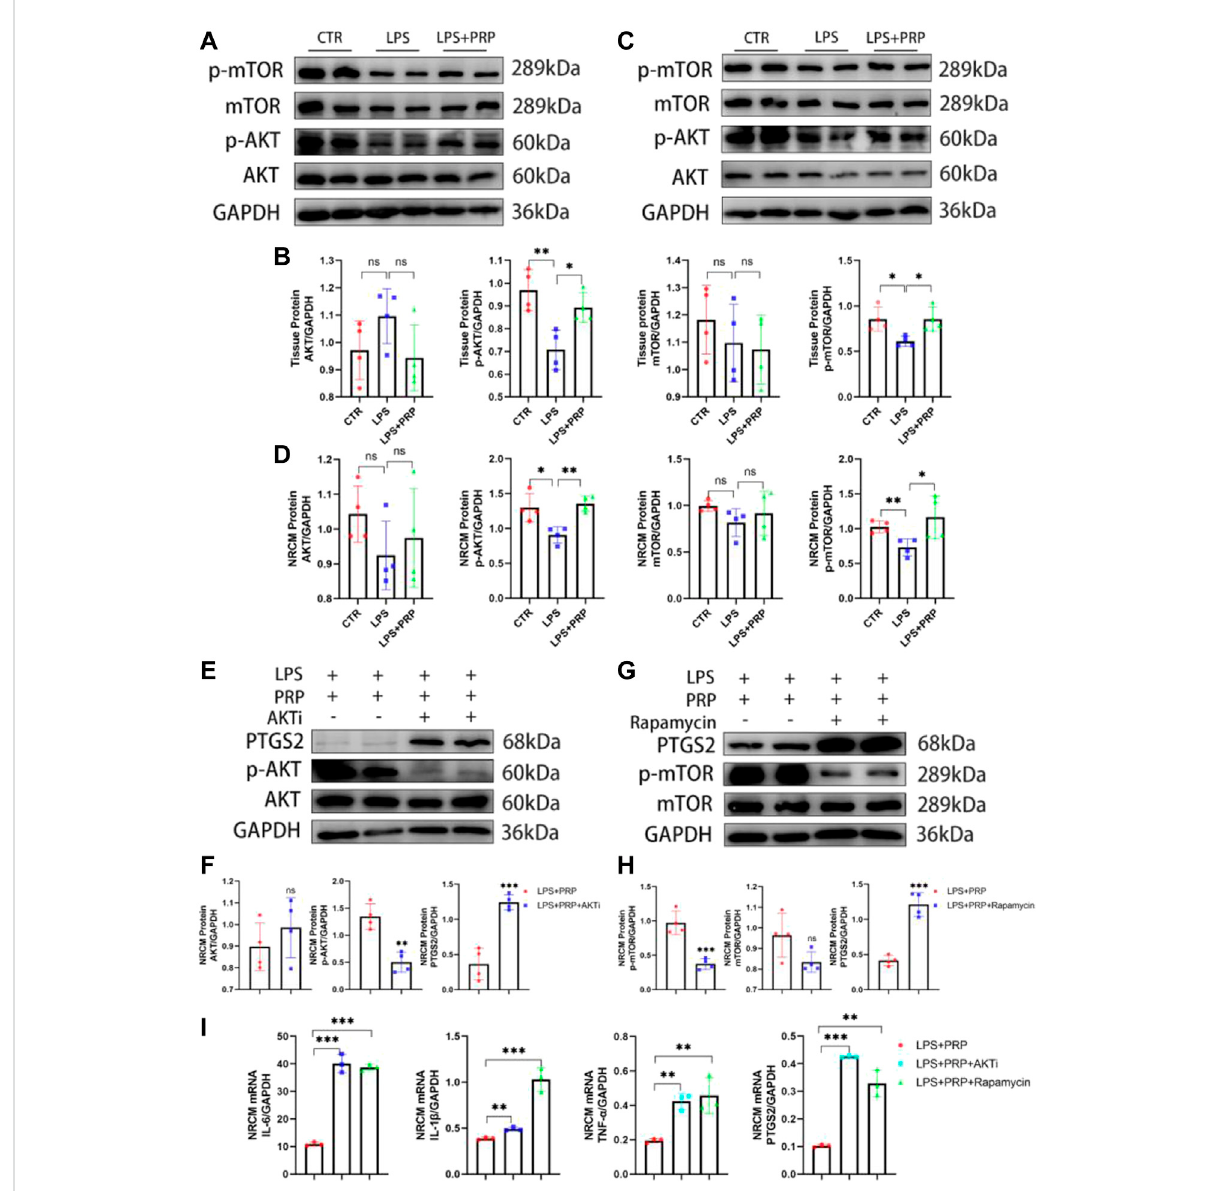
PRP played a protective role through the AKT/mTOR signaling pathway. (A) and (B) The protein levels of AKT, p-AKT, mTOR, and p-mTOR in heart tissues ( n = 4). (C,D) The protein levels of AKT, p-AKT, mTOR, and p-mTOR in NRCMs ( n = 4). (E) and (F) The protein levels of AKT, p-AKT, and PTGS2 in NRCMs after being treated with AKTi ( n = 4). (G) and (H) The protein levels of AKT, p-AKT, and PTGS2 in NRCMs after being treated with Rapamycin ( n = 4). (I) The mRNA expression levels of IL-6, IL-1 β , TNF- α and PTGS2 in NRCMs treated with AKTi and Rapamycin ( n = 3). * indicates p < 0.05. ** indicates p < 0.01. *** indicates p < 0.001. ns indicates p >